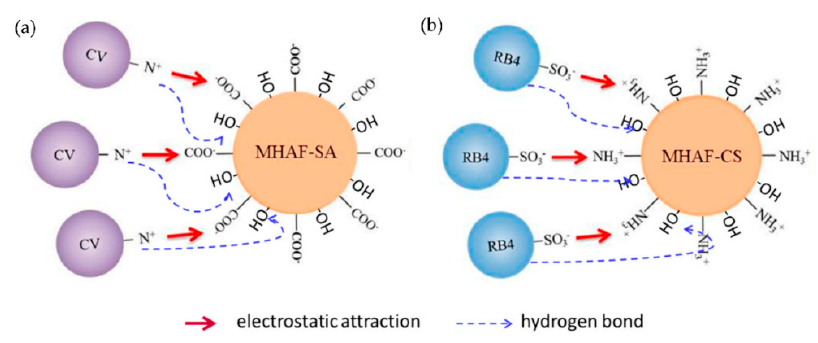
Figure 12. Adsorption mechanism of ( a ) CV onto MHAF-SA and ( b ) RB4 onto MHAF-CS.